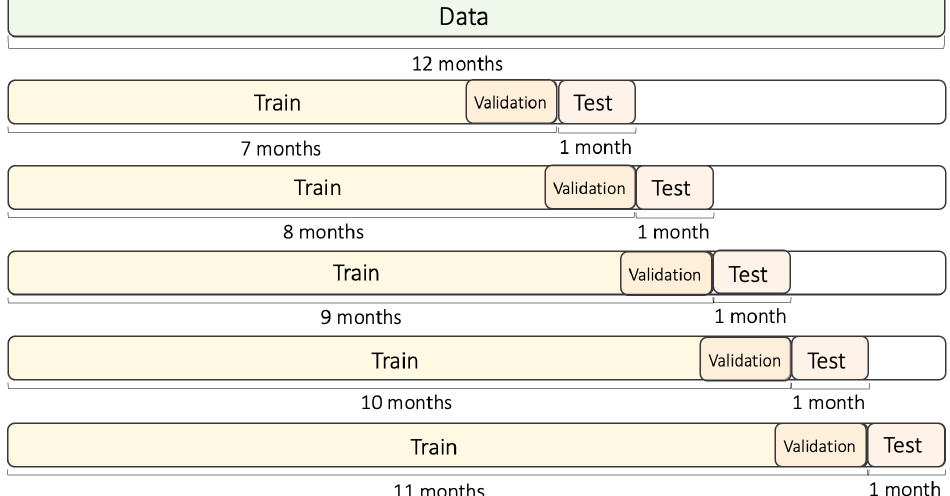
Figure 7. Time series split of the training and testing